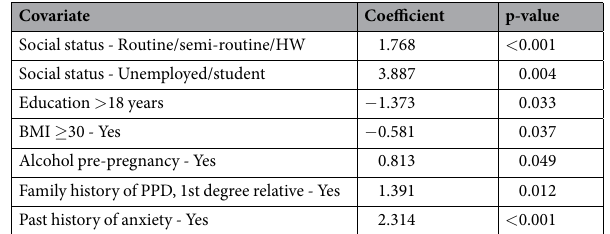
Table 4. Significant covariates of a linear model for antenatal EPDS scores. Positive or negative coefficients indicate by how much the EDPS score increases or decreases with the covariate. The full model is provided in Suppl. Table 5.